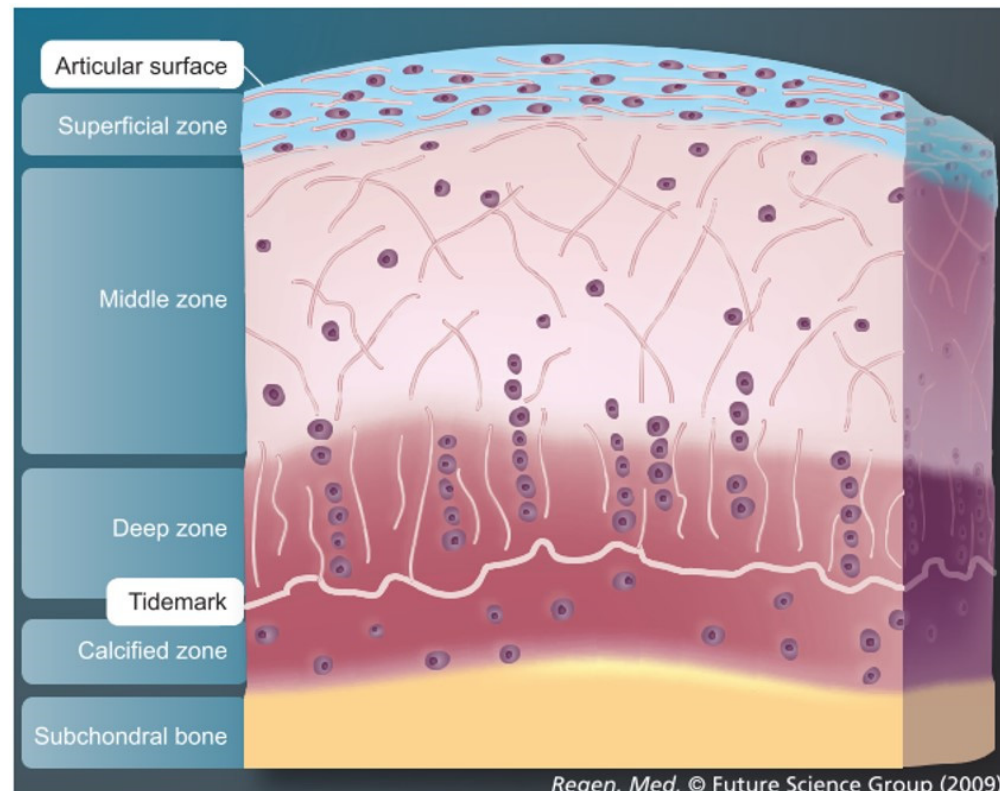
Figure 1. Zonal organization in physiological articular cartilage and subchondral bone showing a schematic distribution of cells and collagen fibril of superficial, middle and deep zones. Articular cartilage image modified with permission from M.J. Stoddart at al., 2009 [1].